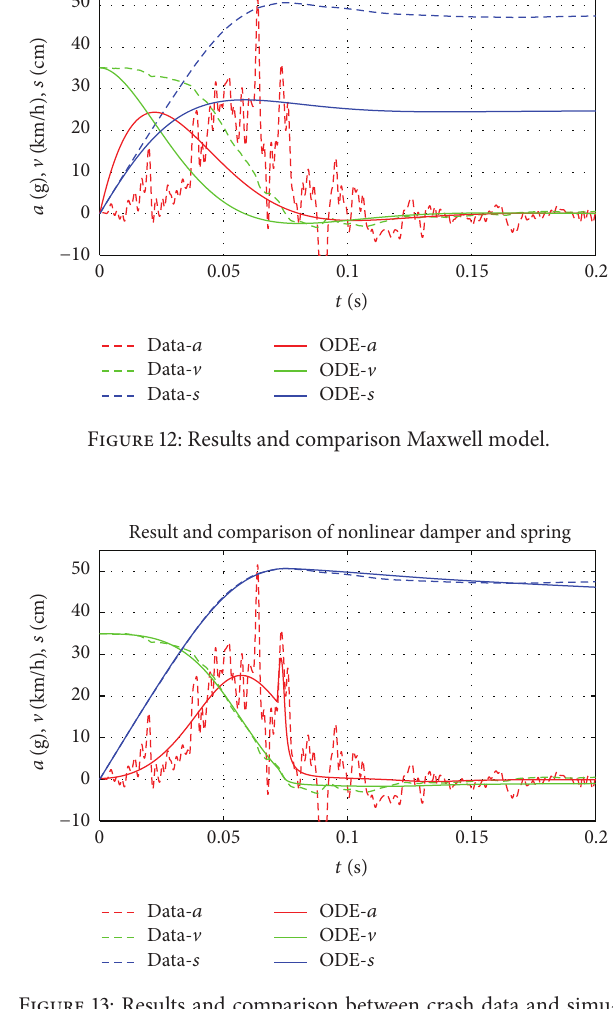
Figure 13: Results and comparison between crash data and simu- lated data.